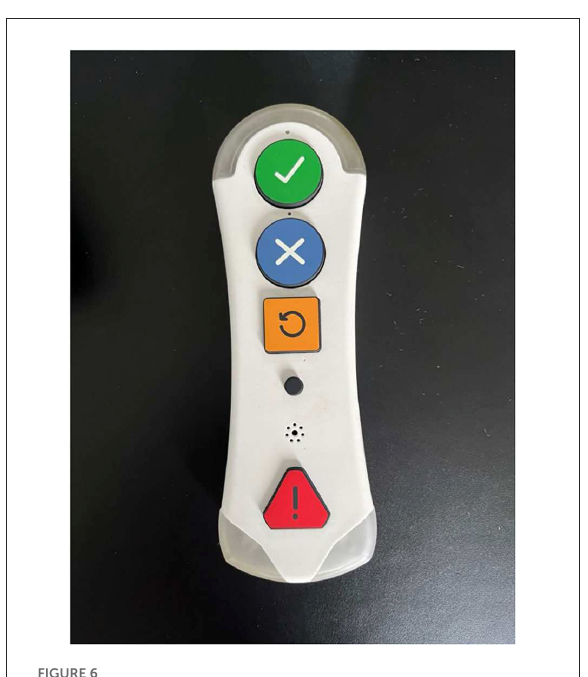
FIGURE6 Kraydel Konnect remote control first